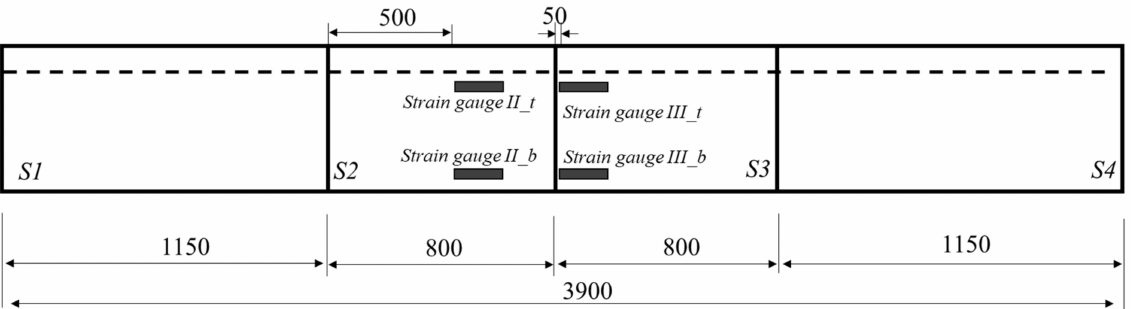
Figure 5. Typical setup for applying the post-tensioning force.